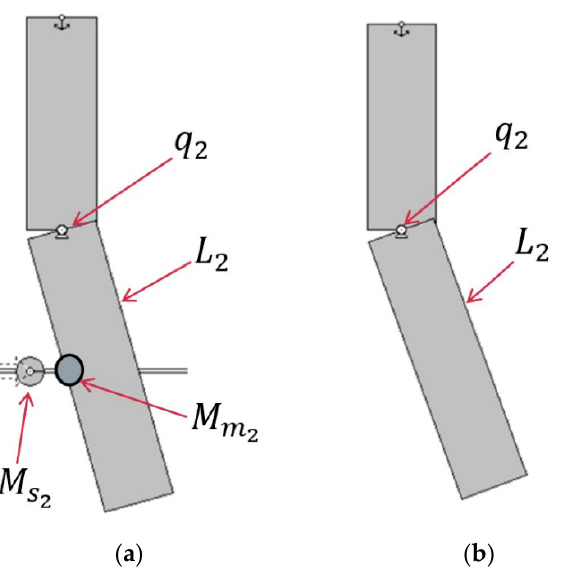
Figure 8. Required mechanical energy in the robot during the circular trajectory with and without the magnetic spring system .